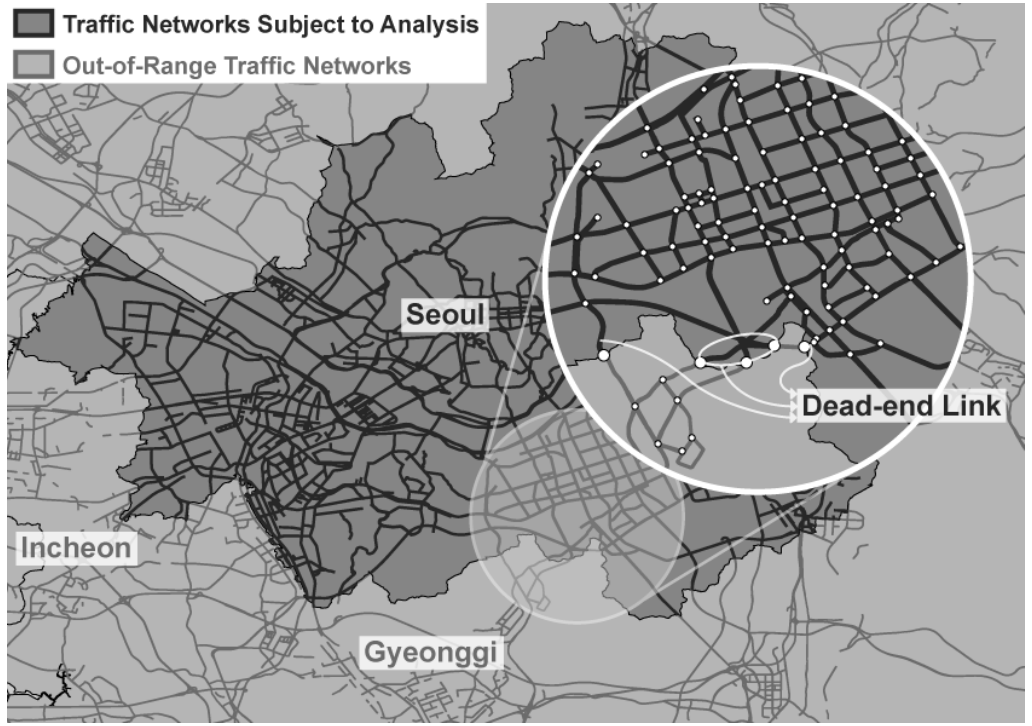
Figure 11. Bridge links between traffic networks subject to analysis and out-of-range traffic network accidentally being recognized as dead-end